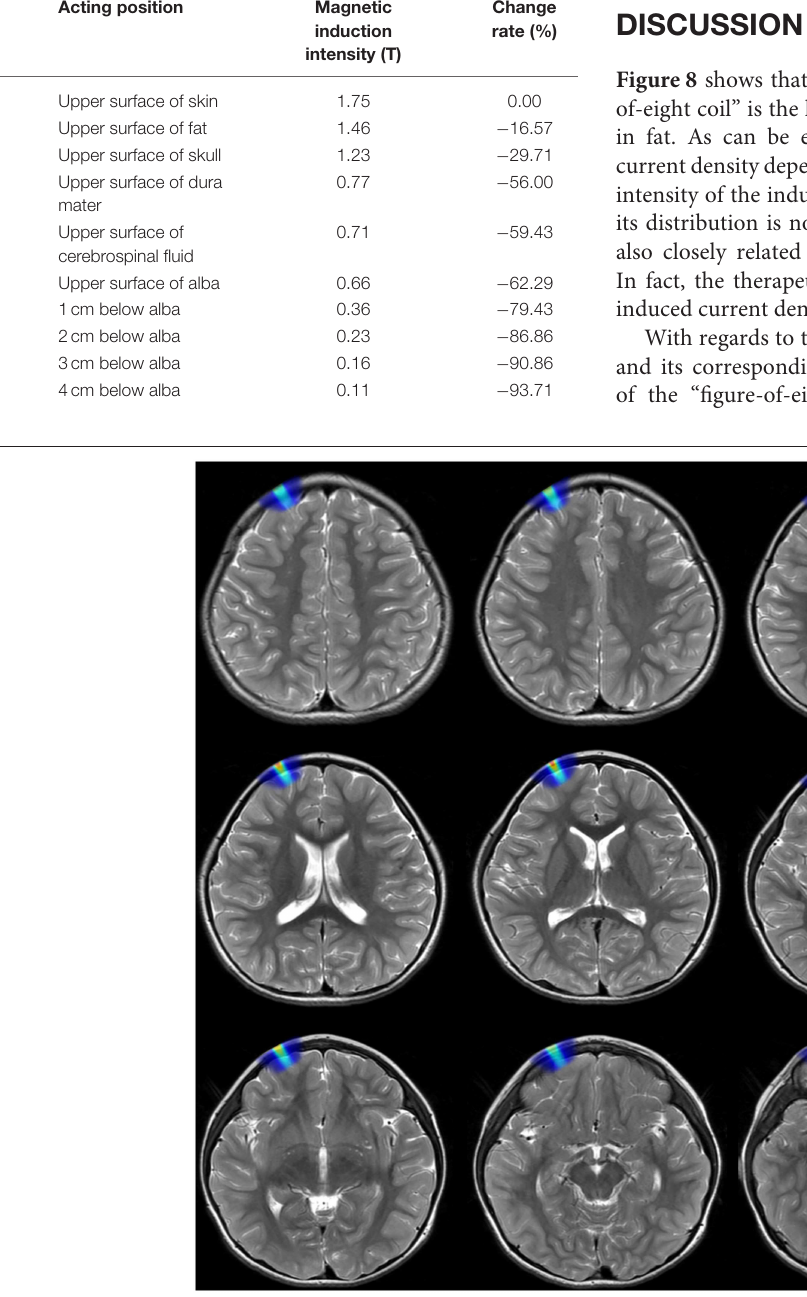
FIGURE 9 | Schematic diagram of the induced electric field in different layers of brain on a preschool child with MRI in depth of 3cm.